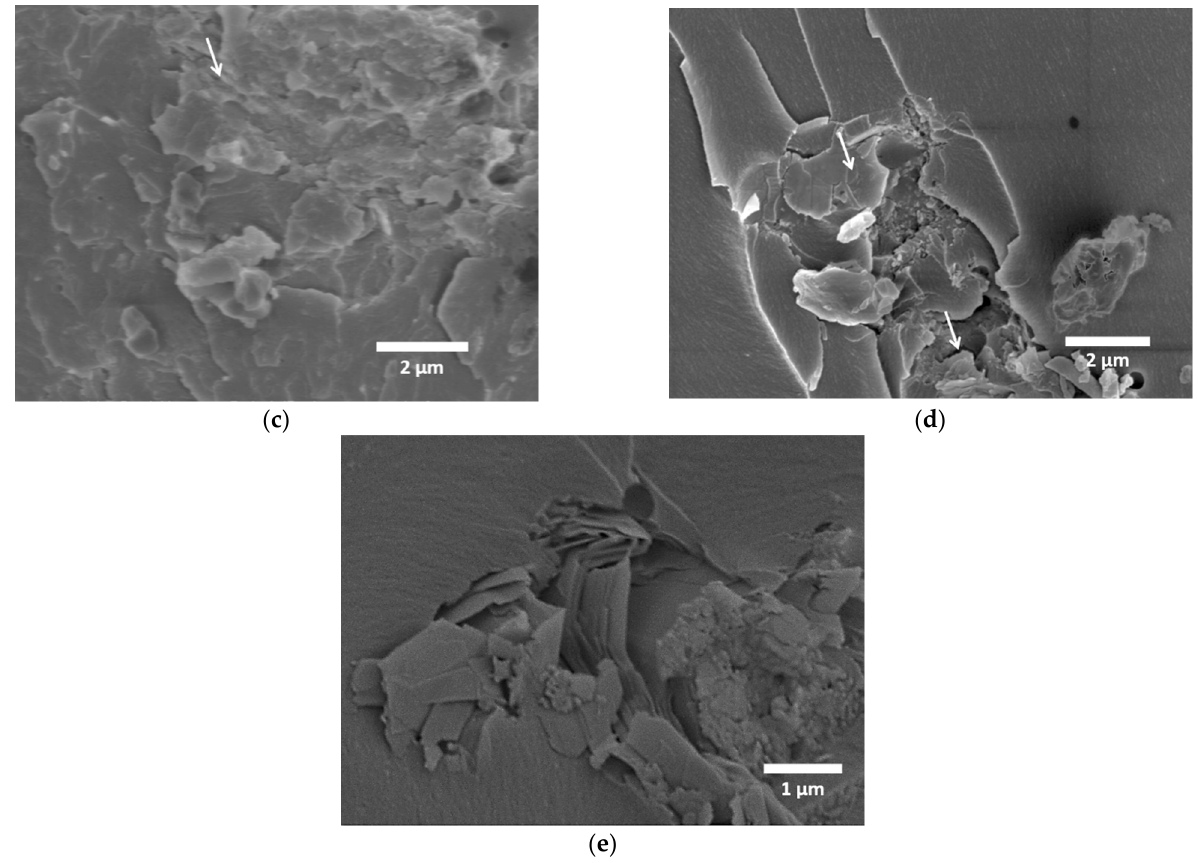
Figure 9. SEM images of fractured sections of ( a ) Epoxy, ( b ) Epoxy/f-MoS2-0.1wt%, ( c ) Epoxy/f-MoS2-0.25wt%, ( d ) Epoxy/f-MoS2-0.5wt% and ( e ) Epoxy/f-MoS2-1.0wt%.